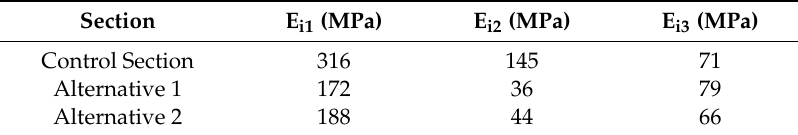
Table 7. Inverse module in the di ff erent layers. Section